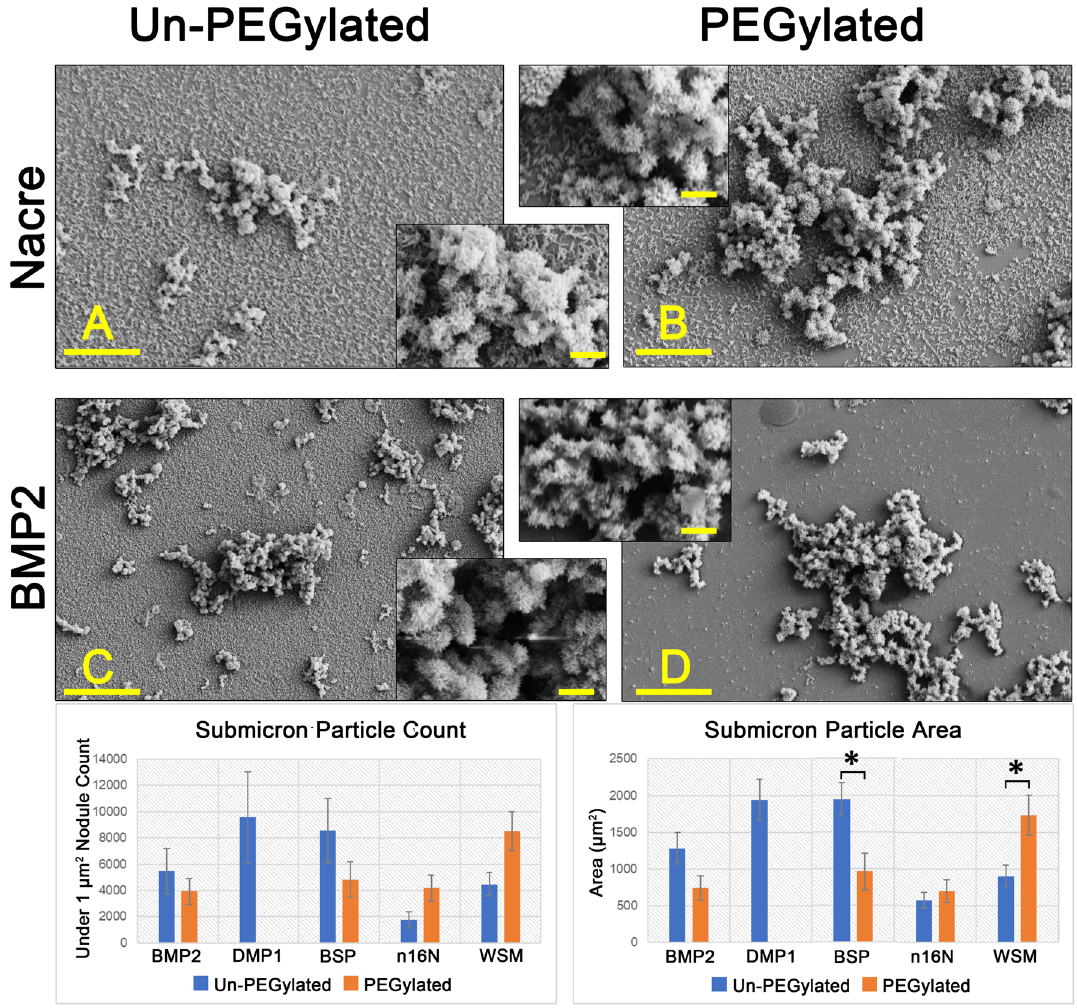
Figure 3. FE-SEM images at ×10,000 magnification of slides coated with ( A ) WSM, ( B ) PEG-WSM, ( C ) BMP2, and ( D ) PEG-BMP2. Mineralization features below 1 µm can be seen as a “dusting of snow” in both non-PEGylated proteins BMP2 and WSM. PEGylation inhibits this type of mineralization in BMP2 but not in WSM as they are present in the PEG-WSM slide but not on the PEG-BMP2 slide. All four samples revealed crystals with an acicular habit. Main scale bars are 2 μm; inset scale bars are 1 μm. Error bars show standard deviation. Asterisks denote significant difference between indicated samples ( p < 0.05). Note No mineralization was observed in PEGylated DMP1